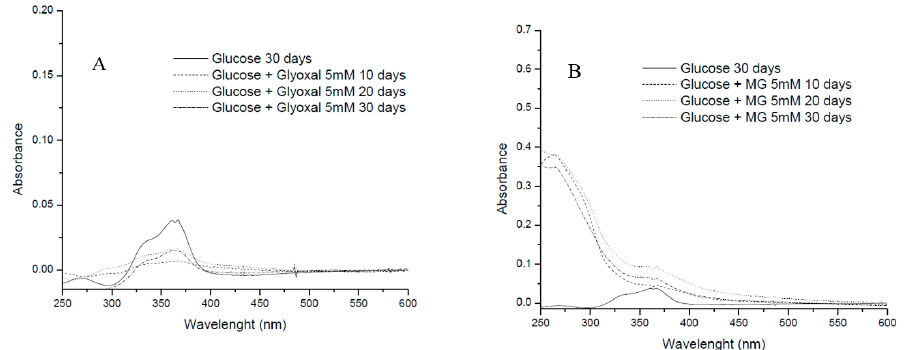
Figure 2. Effect of glyoxal and methylglyoxal in the generation of the major chromophore arising from glucose degradation. Glucose 5 mM was incubated during 10, 20 and 30 days at pH 7.4, 37 °C with glyoxal (5 mM) or methylglyoxal (5 mM). Panels ( A , B ) show absorption spectra of incubated samples during 10, 20 and 30 days of incubation at pH 7.4 and 37 °C.